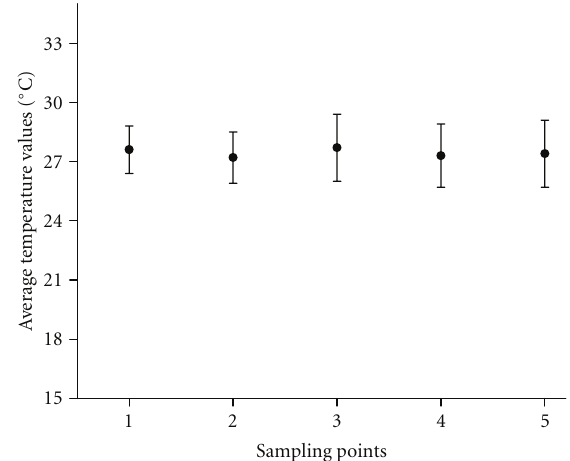
Figure 2: Average water temperature for all of the sampling